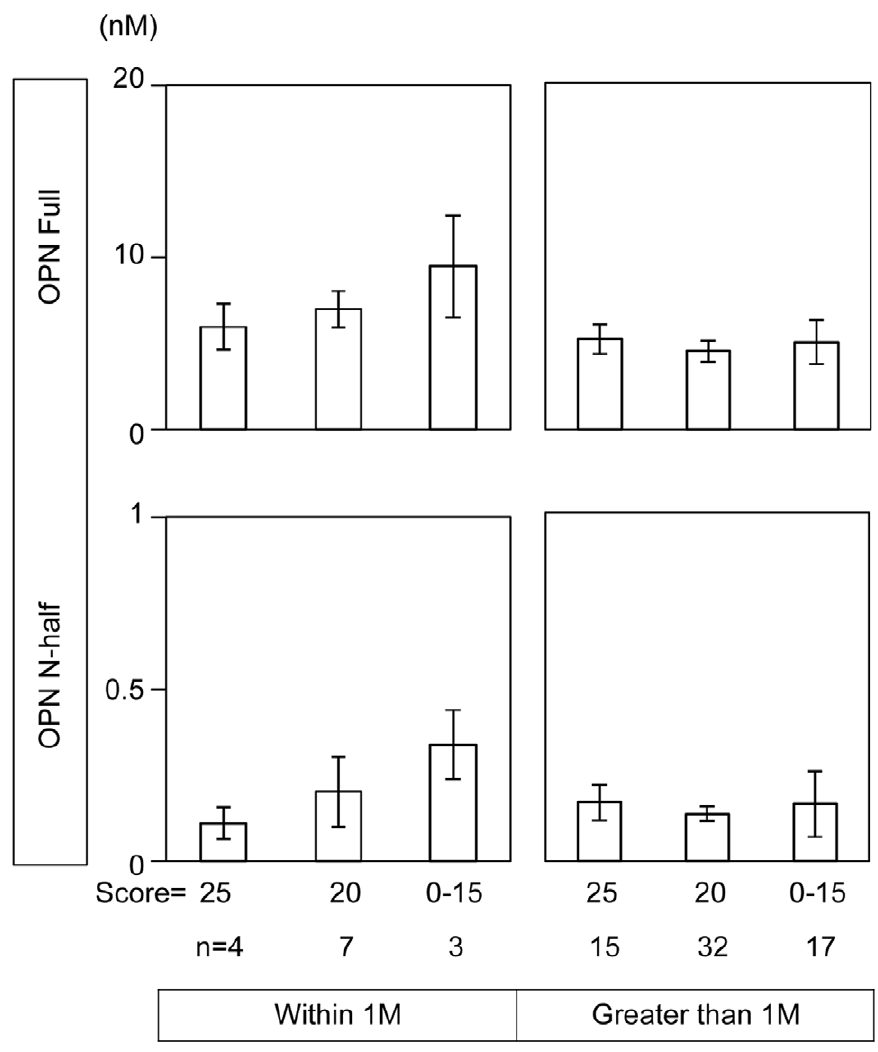
Figure 4. Correlation of OPN Full and N-half levels in synovial fluid with Lysholm scores. Lysholm scores (see Table S3) were collected in an examination room by expert joint surgeons in our university hospital. The basis of the classification of Lysholm score was 25:feel no pain at any time, 20:feel not so severe or tolerable pain even after severe exertion, 0–15:feel severe or intolerable pain sometimes in a daily life. Numbers of samples are indicated below each figure.